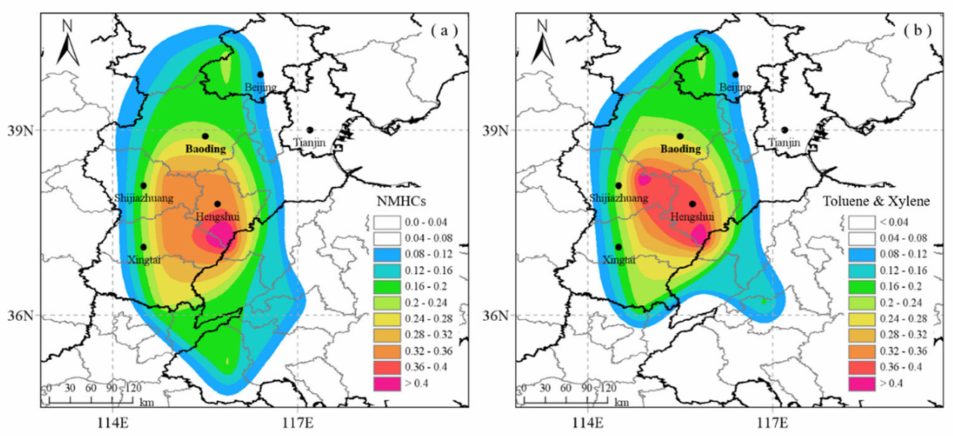
Figure 4. Potential source regions of ( a ) NMHCs and ( b ) aromatics online measured at the S1